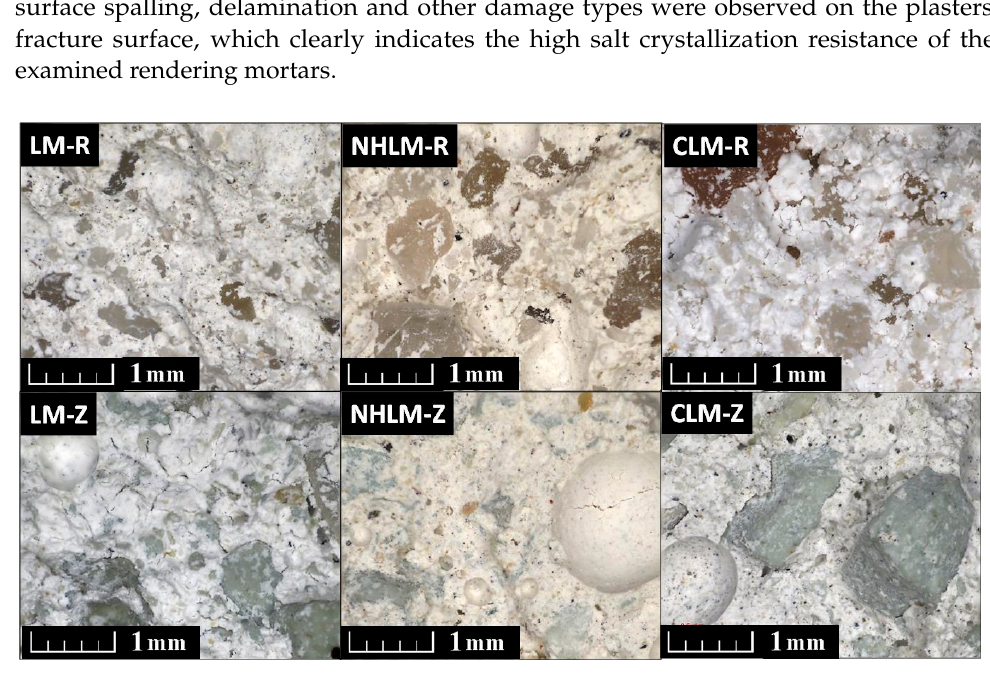
Figure 8. Structure of the renders exposed to the salt crystallization test.